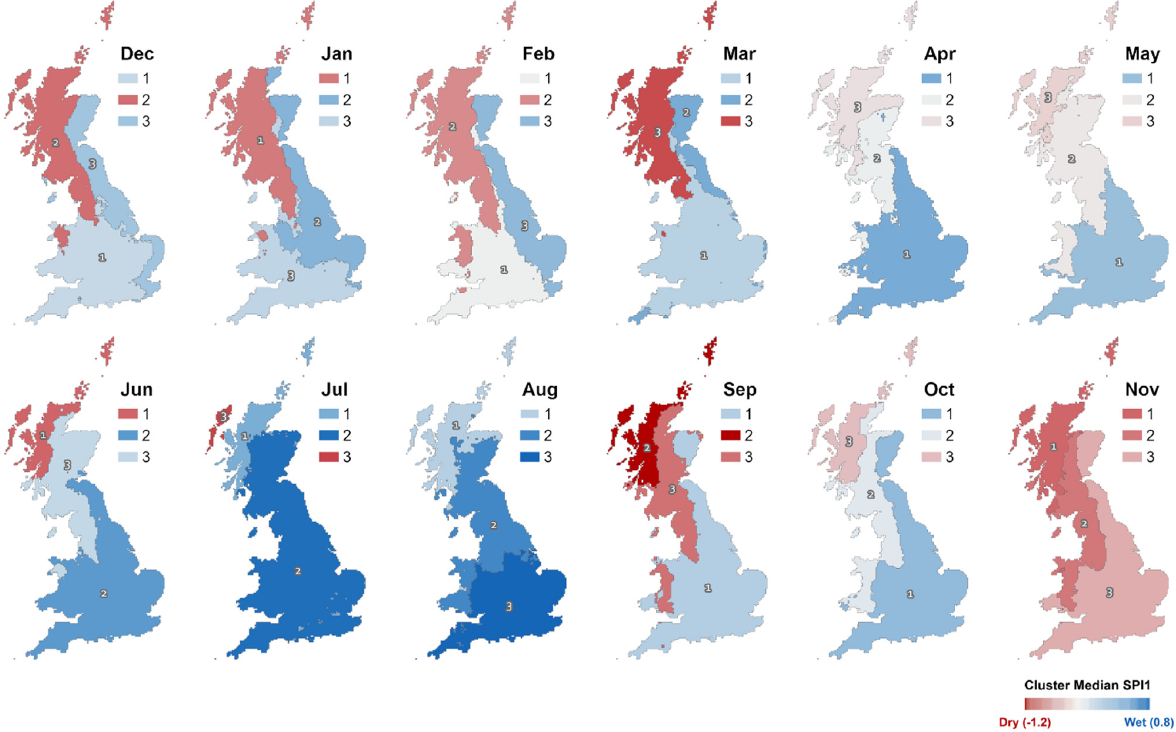
Figure 8. As per Figure 7 but showing the monthly space-time clusters of SPI-1 values under NAO − conditions.